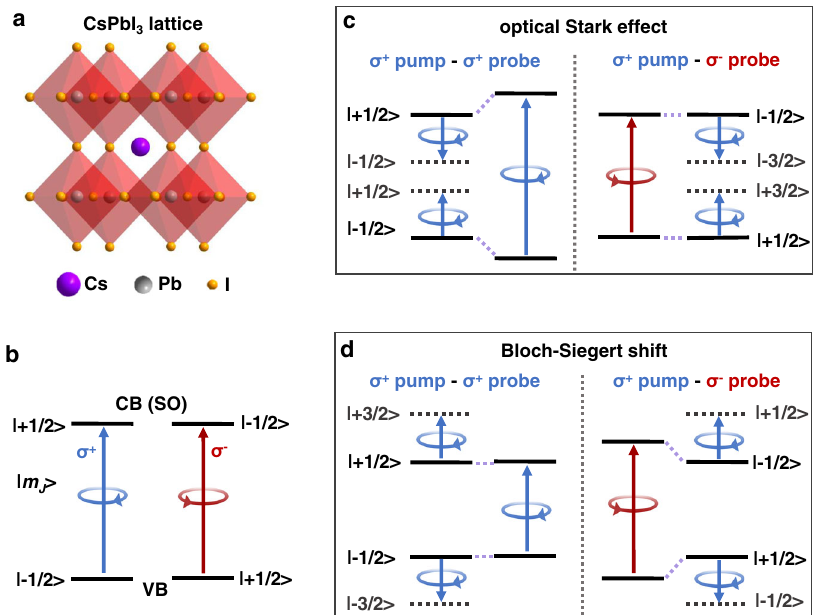
Fig.1|Spin-selectivetransitionrulesandseparationoftheOSEandBSSinlead halide perovskites. a Schematic illustration of the crystal structure of CsPbI 3 perovskite phase. b Conduction band (CB) and valence band (VB) edge states coupledtocircularly-polarizedphotons. c Interactionenergydiagramoftheoptical Stark shift driven by a nonresonant σ + photon, which occurs at the VB| − 1/2 〉 and